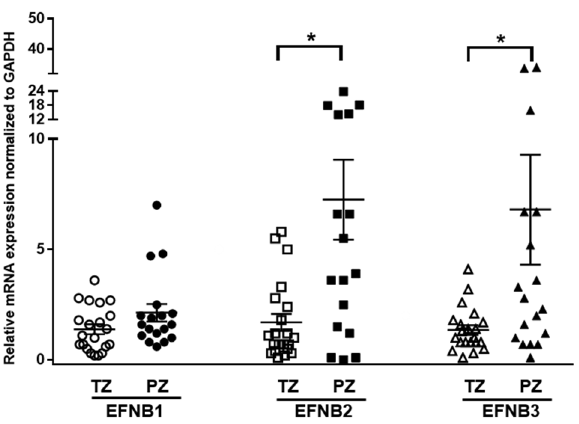
Figure 1. Differential expression of Ephrin B ligands in prostate fibroblasts isolated from the transition zone (TZ) and peripheral zone (PZ) tissues of patients with prostate cancer. Relative expression of Ephrin B1 (EFNB1), Ephrin B2 (EFNB2), and Ephrin B3 (EFNB3) mRNA in fibroblasts isolated from TZ (open shapes) and PZ (solid shapes). Data are shown as dot plots with mean values. Unpaired t -test was used for comparison of Ephrin B ligands expression between TZ ( n = 21) and PZ ( n = 18), * p <